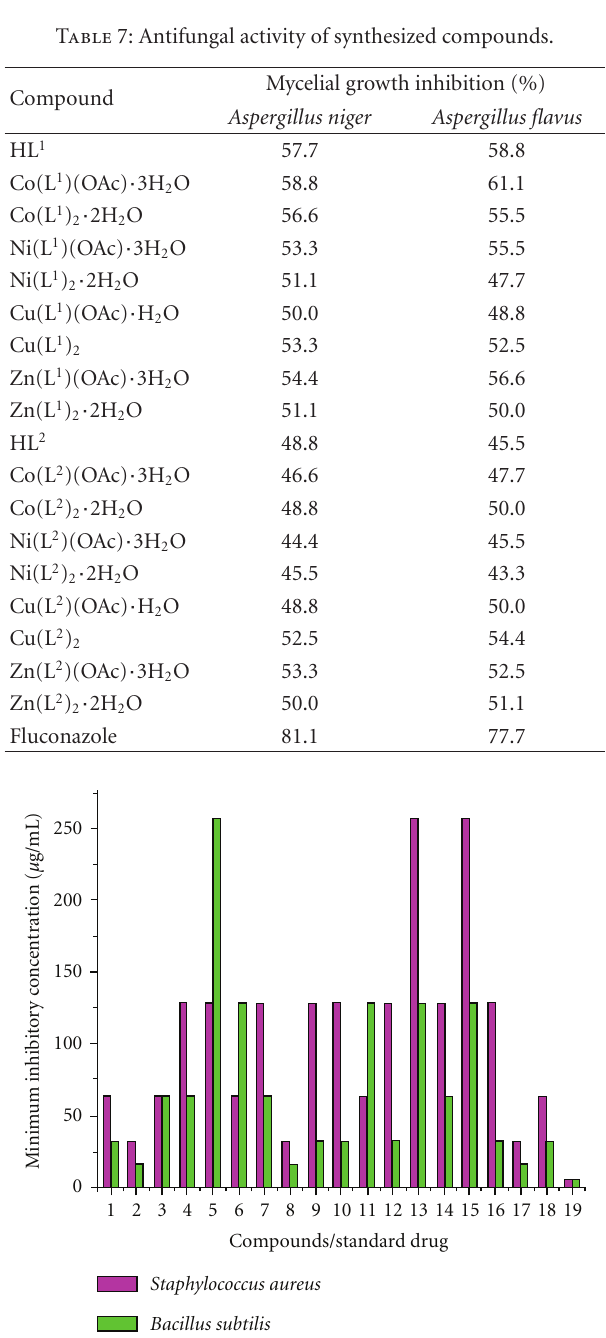
Figure 3: Comparison of minimum inhibitory concentration of compounds with